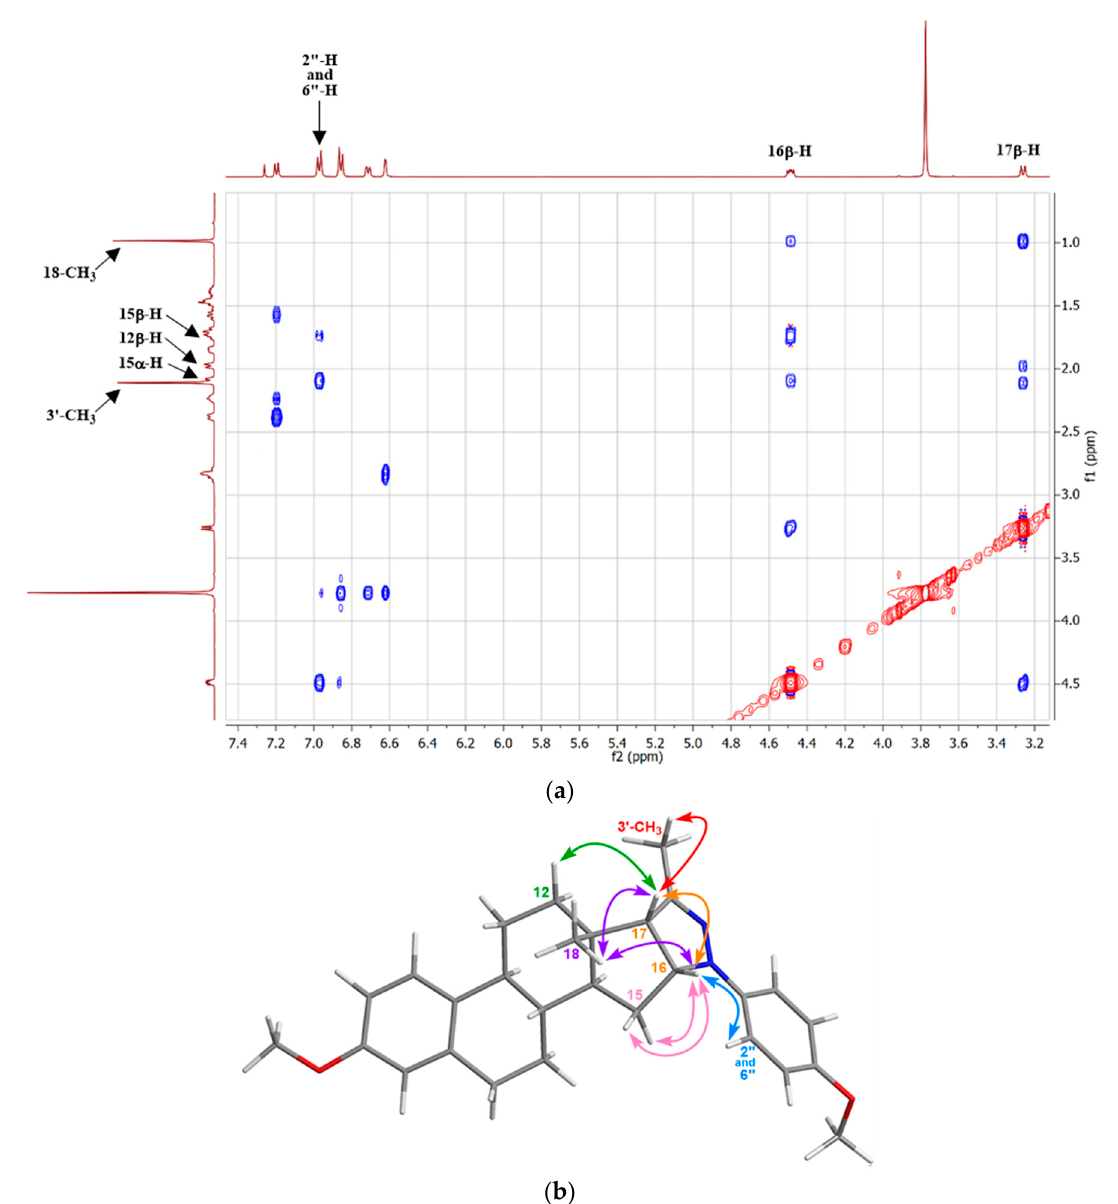
Figure 2. ( a ) Partial NOESY spectrum of compound 17j ; ( b ) NOESY correlations between protons observed for 17j .